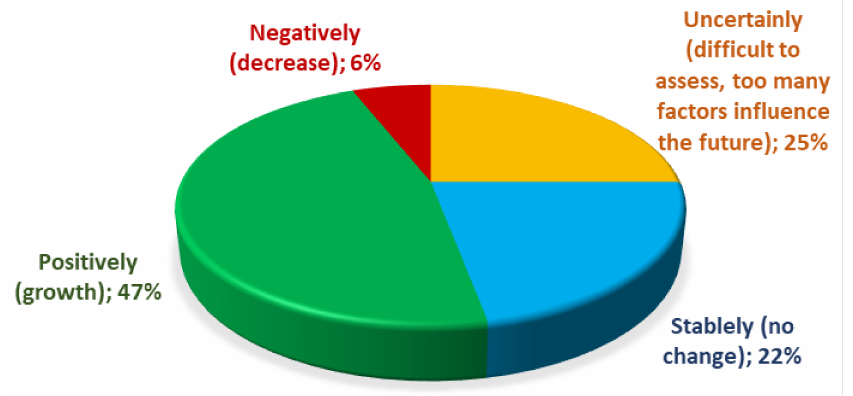
Figure 5. Expert assessment of the future development of the energy industry in Kazakhstan. Source: compiled by the authors based on the results of the